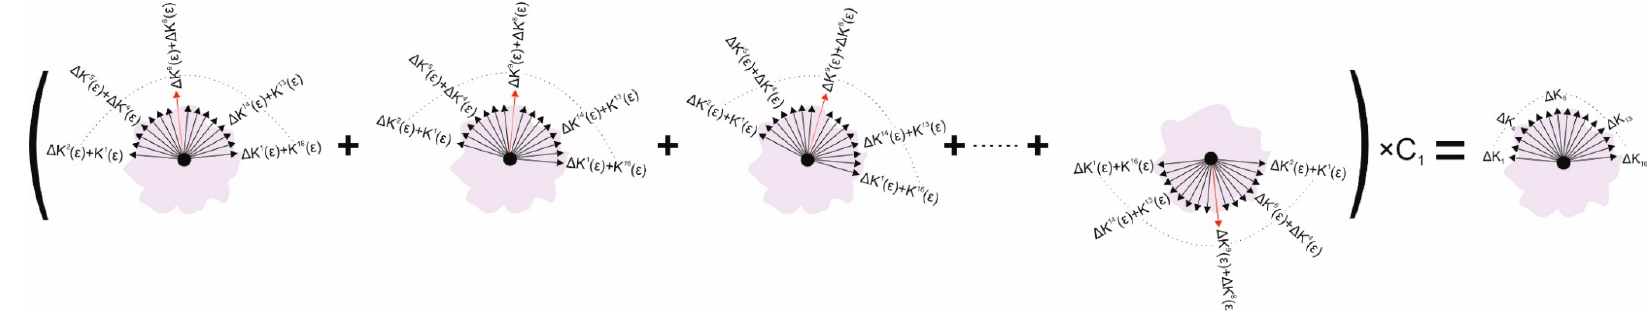
Figure 2. Arithmetic process to simultaneously realise fibril reorientation at multiple discretised orientations. Numbers in superscript depict the 16 discretised fibril orientations. The orientation in red is the principal strain orientation in each of the 16 calculation steps. Orientations 8 and 9 surround the loading direction in the uniaxial test. ∆ K m ( ε ) calculates the change component of fibril content caused by a strain larger than 1% at the orientation in red ( ε > 1%). The superscript m represents the orientation in the quantified relationship between strain and change in fibril density in the uniaxial test. The change components are added together to determine the total changes in fibril density taking place in each orientation. The fibril density related coe ffi cient C 1 represents the averaged fibril density across the 16 orientations at the point and the correction factor that proportionally control the change in fibril density at all 16 orientations.